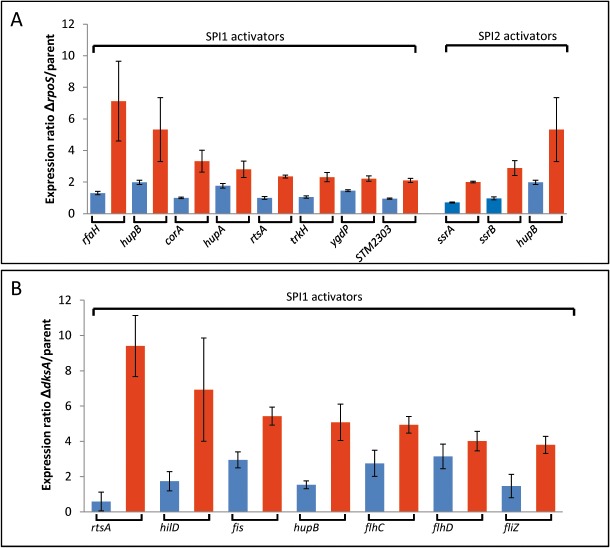
(A) Differential expression (> 2-fold) of known SPI1 and SPI2 activators at LSP and ESP in the ΔrpoS mutant normalised to the parent strain (p < 0.05). Blue and red bars correspond to ESP and LSP respectively [47,48]. (B) Differential expression (> 2-fold) of known SPI1 activators at LSP and ESP in the ΔdksA mutant normalised to the parent strain (p < 0.05). Blue and red bars correspond to ESP and LSP respectively. Data from which the figure was compiled and statistical analysis is shown in S3 Fig and also deposited at Gene Expression Omnibus (GEO), superseries accession number GSE63715.